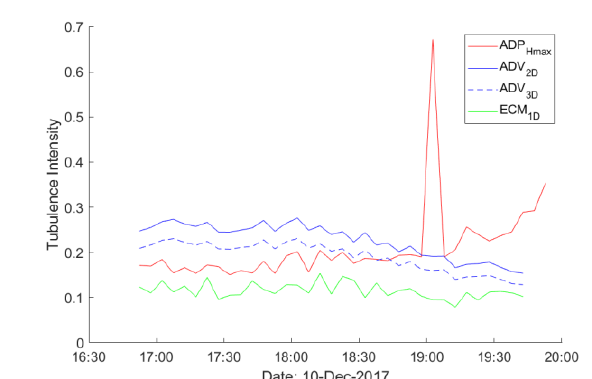
Fig. 6. Sample period showing Turbulence intensity from ADP, ADV and